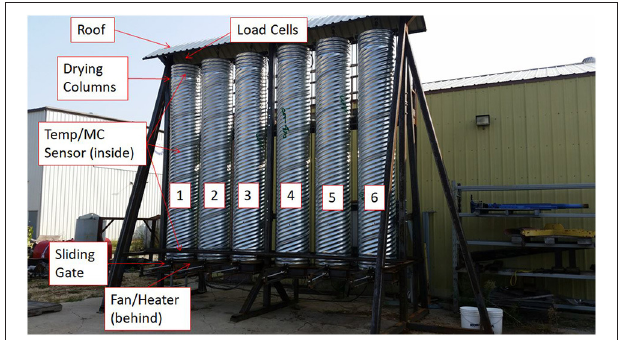
FIGURE 1 | Small-scale natural air drying with real-time monitoring capability, variable fan, and heater test apparatus for six runs.